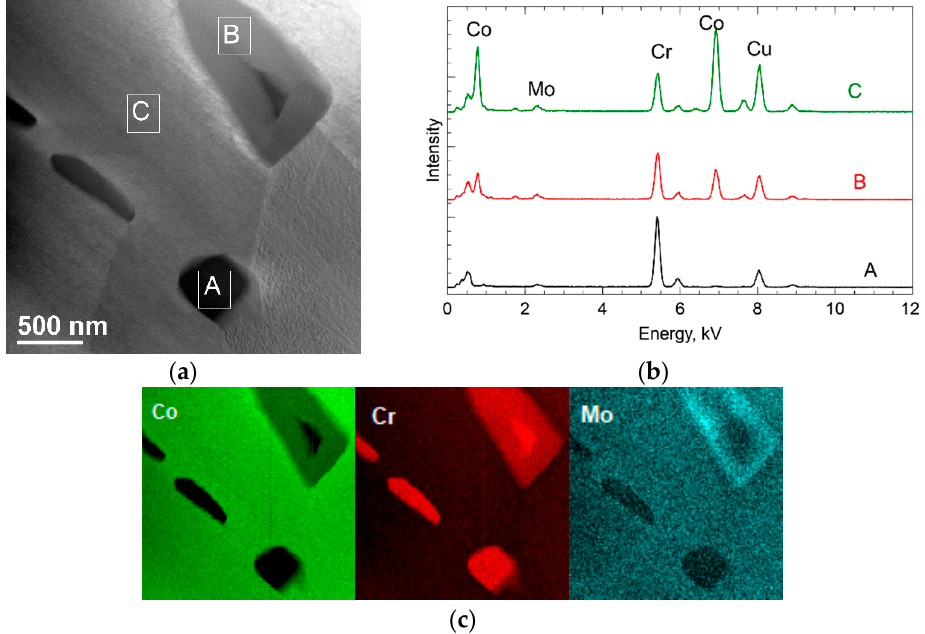
Figure 9. Chemical composition of the precipitates in the Co-PIM sample. ( a ) STEM-HAADF image; ( b ) comparison of EDS spectra at the points indicated in ( a ); ( c ) maps of Co, Cr, and Mo distribution in the area marked in (a). Table 3. Experimental results (wt.%) of STEM-EDX analysis at the points indicated in Figure. 9a. n.d. = not determined.